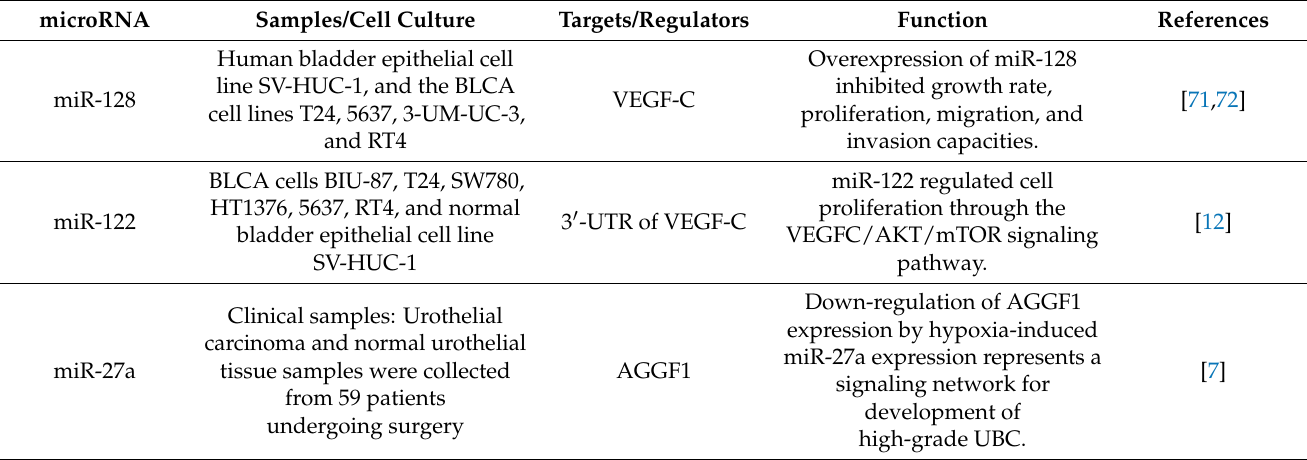
Table 4. miRNAs involved in angiogenesis inhibition in